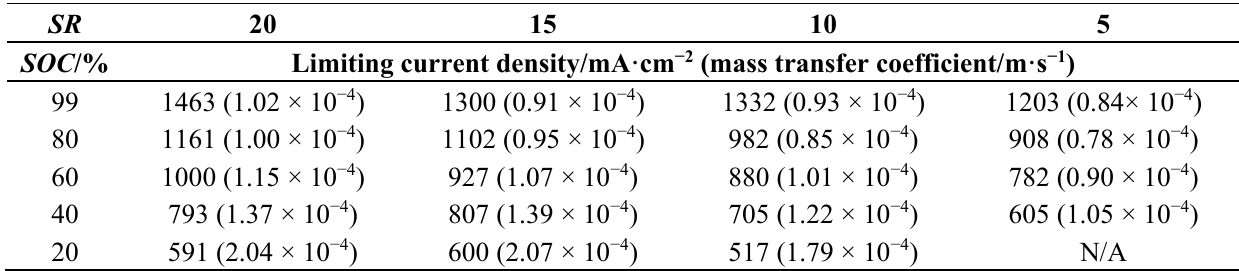
Table 2. Values of limiting current density and mass transfer coefficient obtained from Figure 3 and Equation (3).